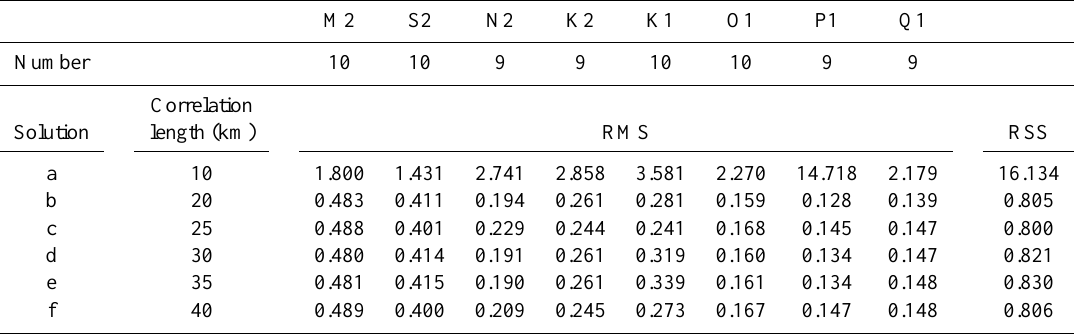
Table 7. RMS and RSS of the differences between the control data set (i), not used in the assimilation and the solutions computed with different decorrelation lengths. Famagusta control station includes 4 constituents. Unit